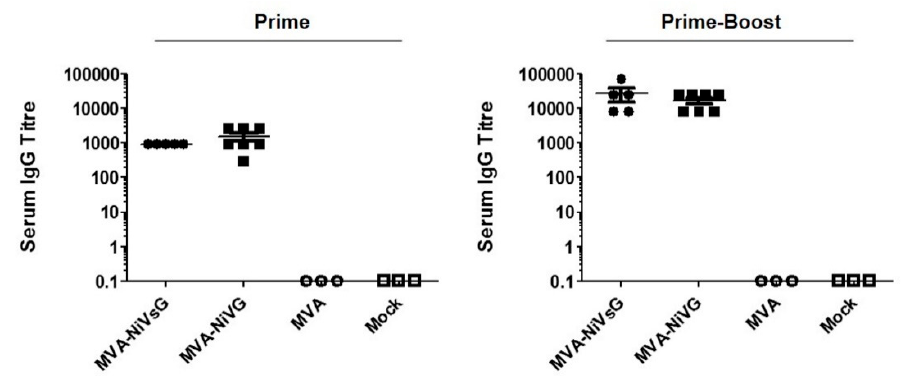
Figure 2. Antigen-specific humoral immunity induced by treatment with recombinant MVA vaccine candidates expressing NiV-G. IFNAR − / − mice were immunized and boosted 21 days later with 10 8 PFU of MVA–NiVsG or MVA–NiV-G via the intramuscular (i.m.) route ( n = 3–7 per group). Mice inoculated with MVA or saline (mock) were used as controls. Sera collected 18 days after the first immunization (Prime) and 10 days (Prime-Boost) after the last immunization were analyzed for NiV-G-specific IgG titers by ELISA. Graphs show the antigen-specific serum IgG titer.